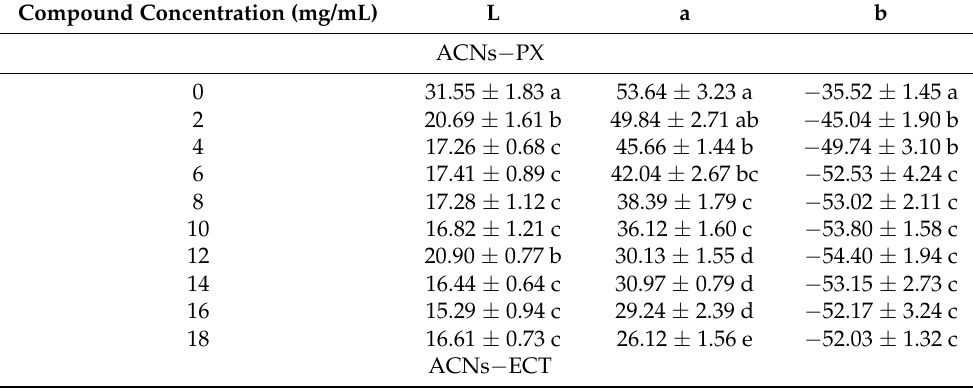
Table A1. The effects of the optimised compound concentration on the CIE Lab